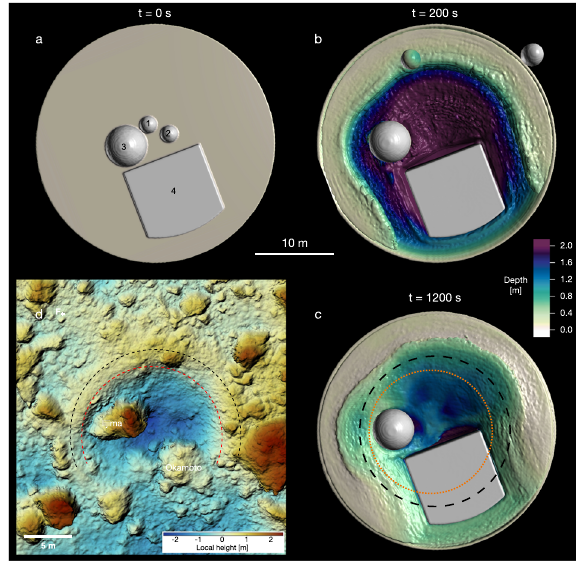
Fig. 2 | End-to-end SPH simulation of the SCI impact. a – c Snapshots of the simulationareshownatdifferenttimes.At t =1200sthecraterevolutionis fi nished. d Observed SCI crater on Ryugu 2 . The local height is measured relative to point F . The crater dimensions are also indicated by the dotted orange (crater wall) and dashedblack(craterrim)linesin c .Theoveralloutcome intermsofcratersizeand boulder displacement iswellreproduced. In the simulation, the largest block (4) is moved by 10 – 20cm and the medium boulder (3) by 2m, which is roughly con- sistent with theobserved displacement of the large bouldersatthe SCI impactsite (36cm for the large Okamoto boulder; 2.58m for the medium sized Iijima boulder; 20 ). In the simulation, the small boulders(1,2) are ejected out of the crater, as observed in the case of the SCI impact for some of the boulders (e.g. boulders mb01 and mb02 ; ref. 20).